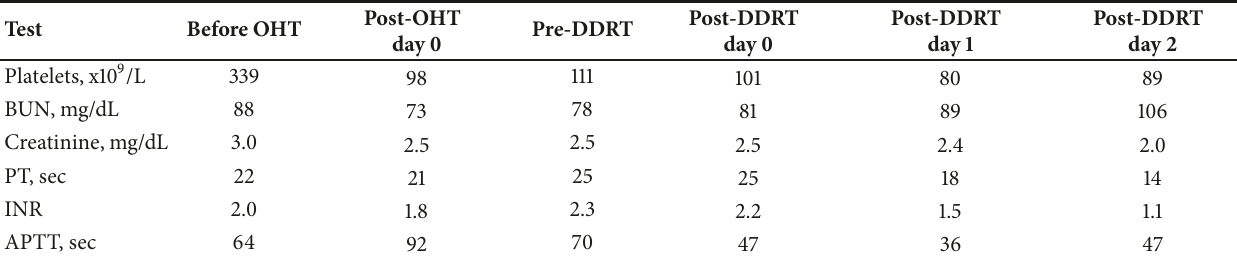
Table 1: Laboratory results before and after OHT and DDRT.